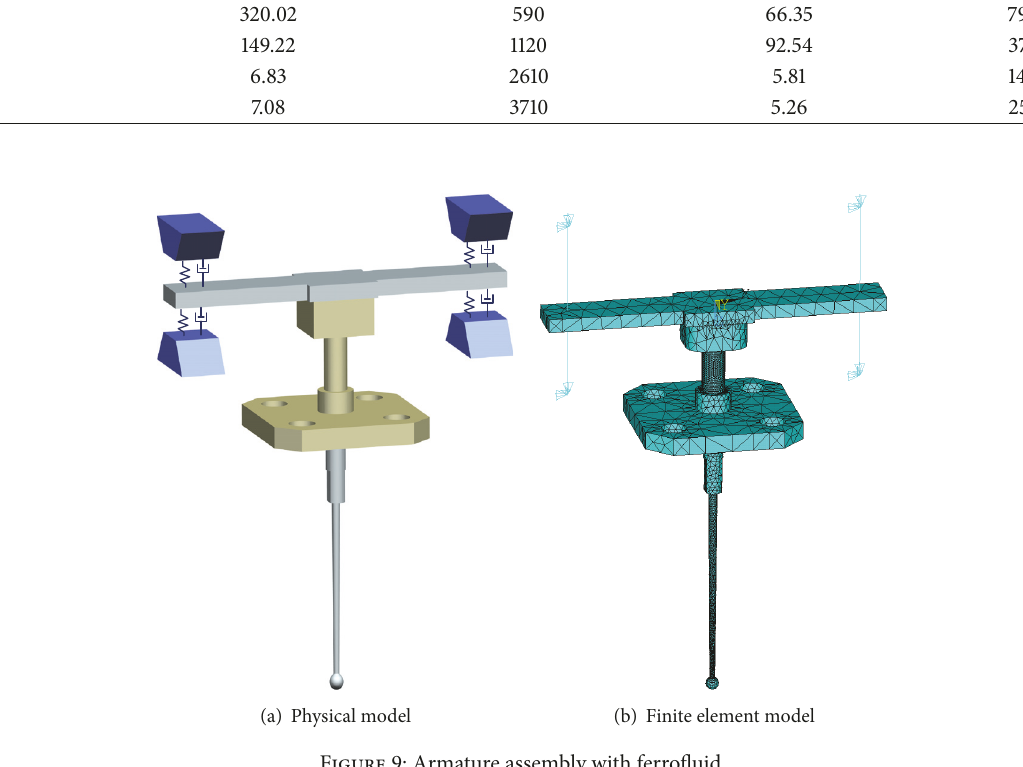
Figure 9: Armature assembly with ferrofluid.